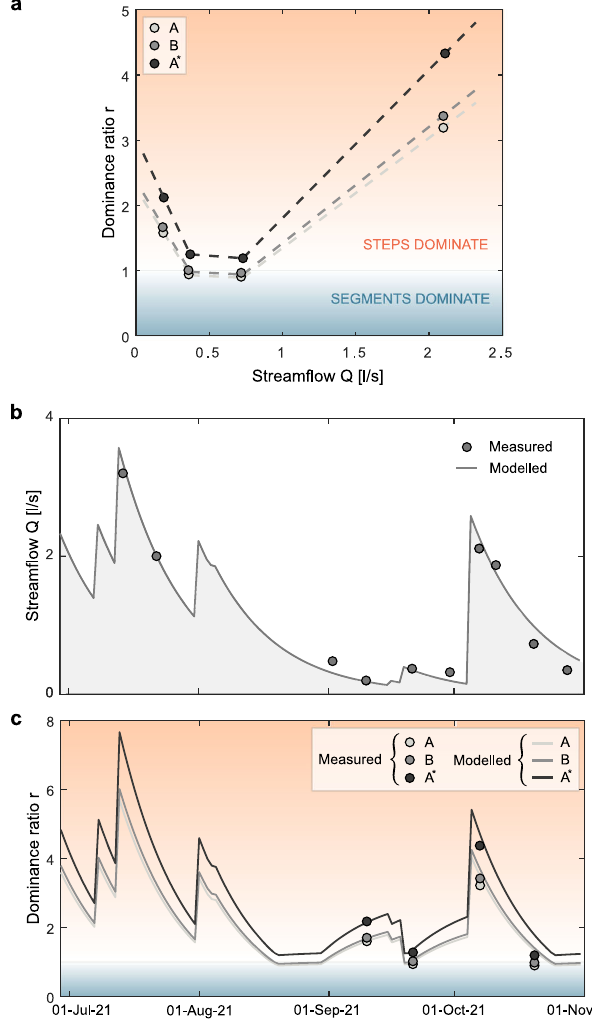
Fig. 4 | Dominance ratio variations induced by changes in the underlying hydrologicconditions. a dominanceratioasa function ofthe stream discharge Q in the reaches A (light gray), B (gray) and A * (black). Circles represent the observed valuesof r ,thedashedlinesshowalinearpiece-wiseinterpolation.When r >1,steps dominate the outgassing (upper region of the plot). b Temporal dynamics of the discharge in the reference segment of the focus reach from July 1 to Nov 1, 2021. Observed stream fl ows are indicated as gray dots, while the simulated discharges (see “ Methods") are shownbythe shaded-gray region. c Temporaldynamicsof the dominance ratio during the same time window (shown in b ), for reaches A (light gray), B (gray) and A * (black). Circles refer to the observed values, while the solid linesrefertosimulatedvaluesestimatedbasedonthesimulateddischarges(shown in b ) using the piece-wise linear interpolation between r and Q (shown in a ). When r >1 the steps dominate the outgassing (upper region of the